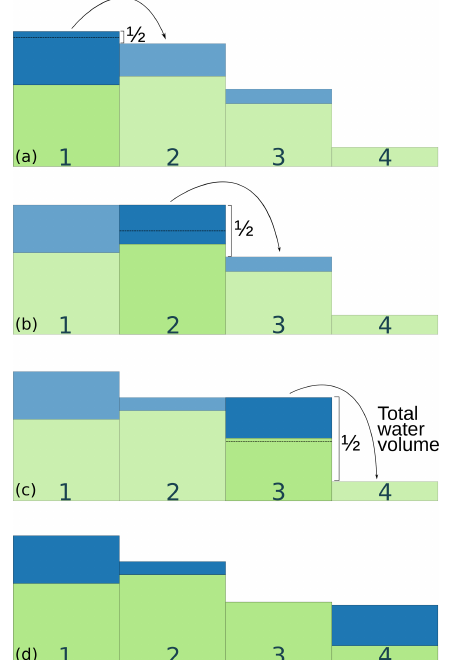
Figure 3. Water flow during a single iteration of FlowFill. In each iteration, water is moved starting with the highest (wa- ter + topography) cell and ending with the lowest. Each “target cell” routes water into its steepest downslope neighbour. The amount of water moved from the higher cell to the lower one is the min- imum of either all the water available in the target cell or half the difference in elevation between the target cell and its steepest downslope neighbour. This latter criterion ensures numerical sta- bility but slows convergence towards a solution. (a) Starting at the highest (topography + water depth) cell, half of the difference in to- pographic + water thickness height is moved from cell 1 to cell 2, this being the steepest downslope direction. (b) Cell 2 becomes the target cell. Half of the difference between cells 2 and 3 is moved to cell 3. (c) Cell 3 becomes the target cell. There is less water avail- able in cell 3 than half the difference between cells 3 and 4, so all of the water from cell 3 is moved to cell 4. (d) Cell 4 becomes the target cell; if this were the edge of the domain, the water in cell 4 would flow out of the domain. A single iteration has been completed. Wa- ter will now start moving from cell 1 again, and the process will repeat until the solution